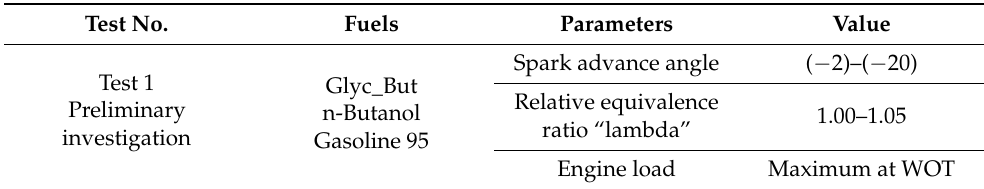
Table 3. Test matrix. Test No. Test